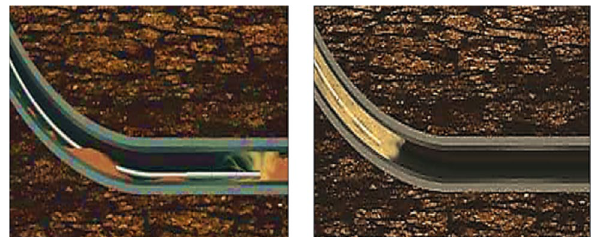
Fig. 1 Sand removal procedure (Ali et al. 2004)